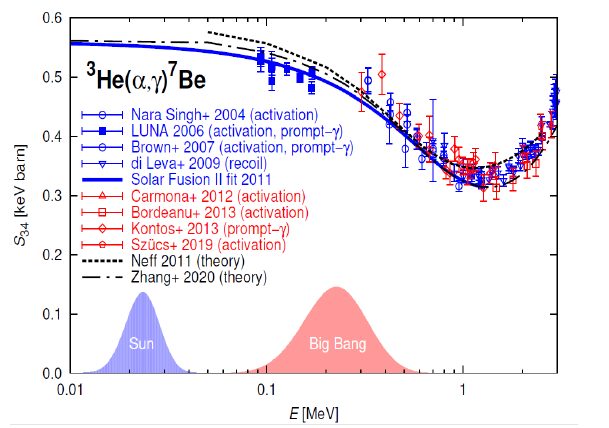
Figure 1. Astrophysical S-factor of the 3 He( α,γ ) 7 Be reaction as a function of energy. The Felsenkeller gas-jet will help to perform comprehensive measurements of the reaction covering the entire BBN range.